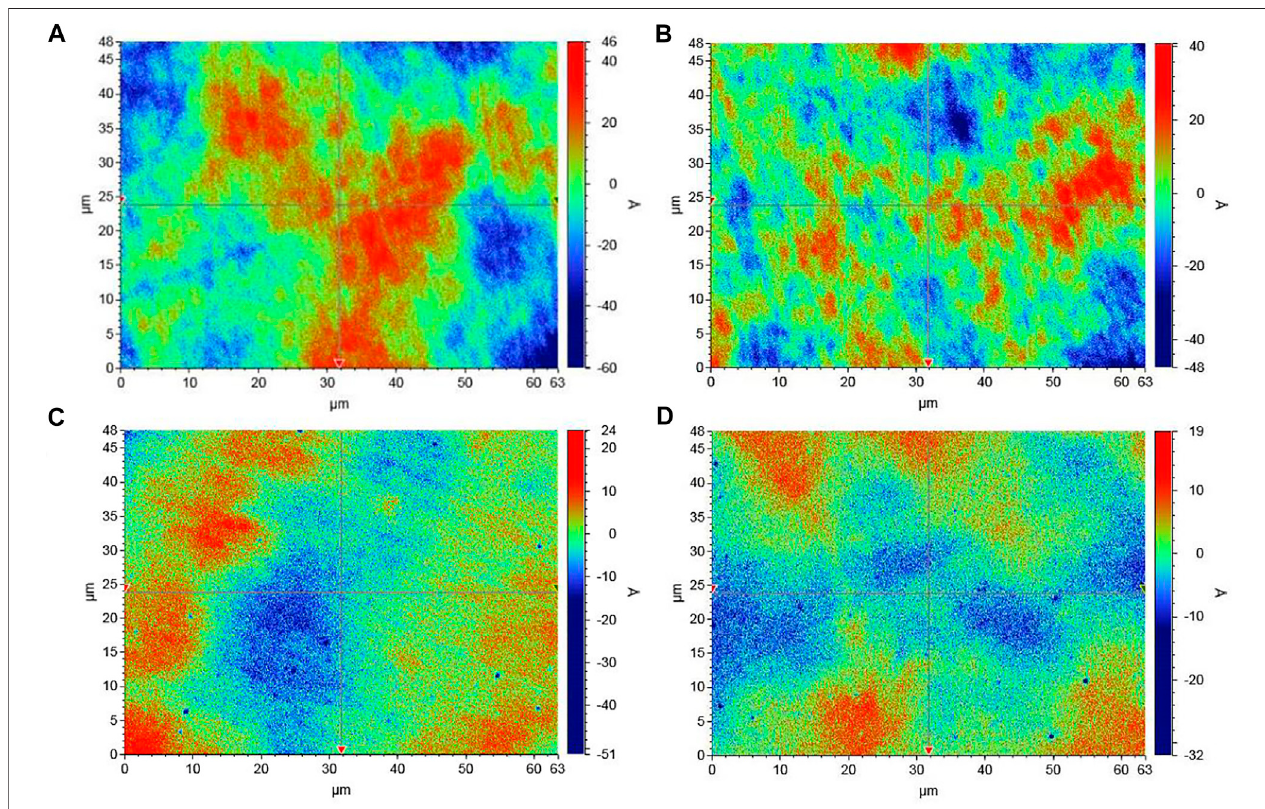
FIGURE 4 | WLI morphology images of GaSb wafers under the polishing solution with dilution ratios of (A) 1:3, (B) 1:7, (C) 1:10 and (D) 1:20.